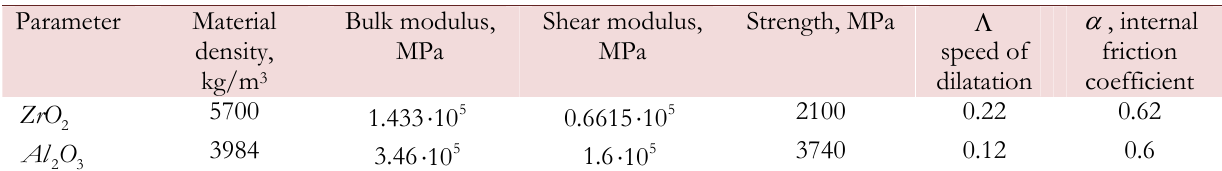
Table 1: The physical-mechanical properties of the materials compounding the composite. The macroscopic behavior